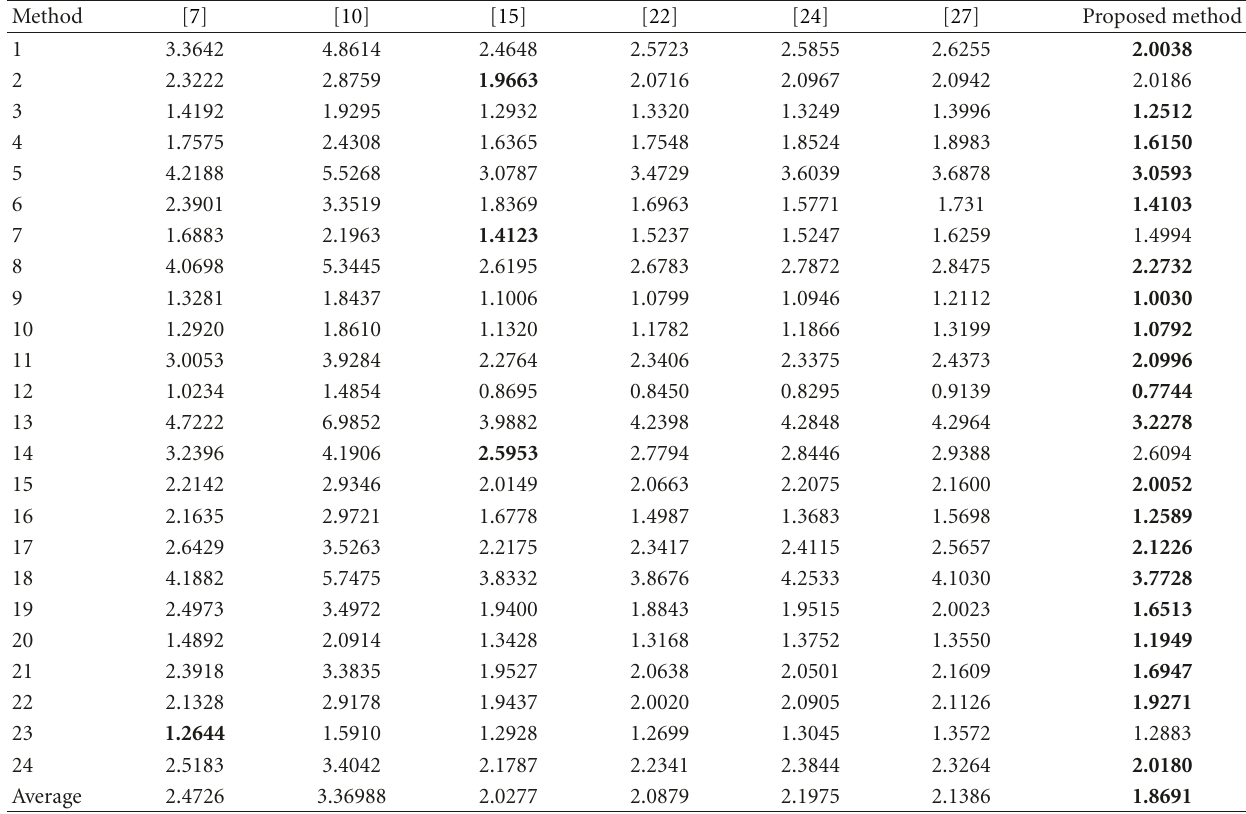
Table 2: NCD comparison of color demosaicing algorithms.